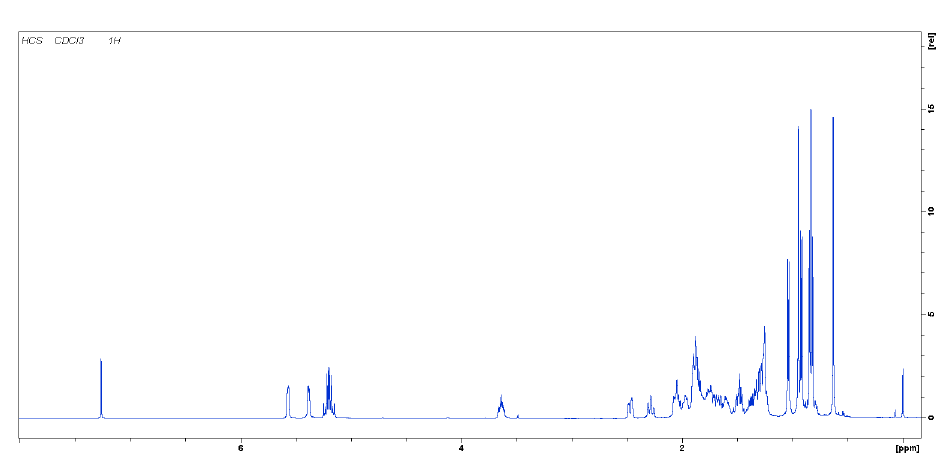
Figure A3. Analysis of main compounds with retention times of 40 min in HPLC by 1 H NMR.